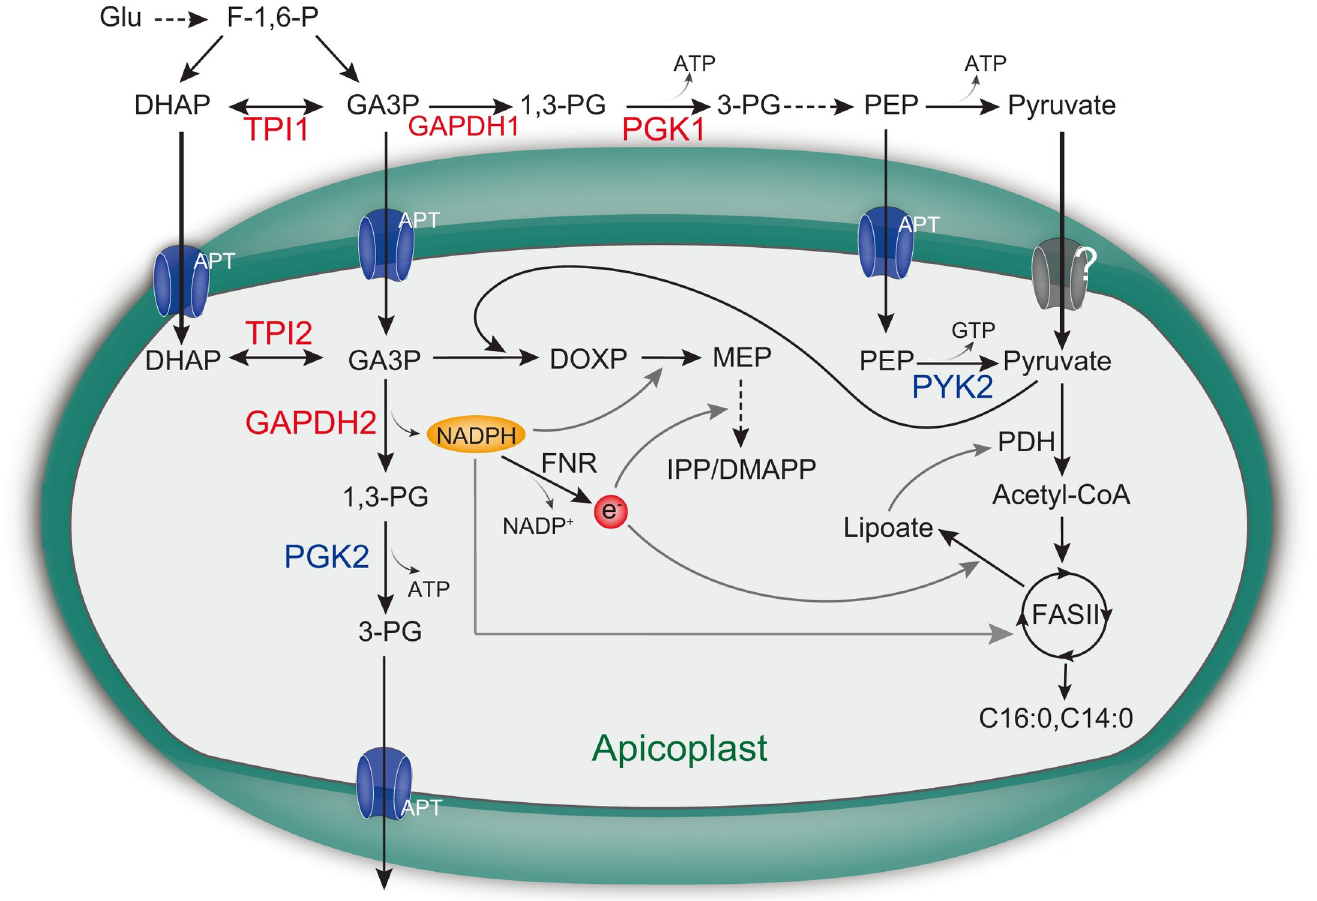
Fig 9. A model for the functions of glycolytic enzymes in T . gondii apicoplast. The apicoplast phosphate translocator (APT) imports a number of glycolytic intermediates into the apicoplast, including DHAP, GA3P and PEP. TPI2 catalyzes the interconversion of DHAP and GA3P, providing carbon source (GA3P) for the MEP pathway. The other substrate for the MEP pathway, pyruvate, may be acquired by multiple routes, through the conversion of PEP catalyzed by PYK2 and the direct import from cytosol by an unknown transporter. Dispensability of PYK2 suggests that direct import is probably the main source for pyruvate in the apicoplast. In addition, the lack of a strong growth defect of the Δ pyk2- Δ pgk2 mutant indicates additional source of energy to power apicoplast metabolism. GAPDH2 catalyzes the conversion of GA3P to 1,3-PG, along with the generation of reducing power in the form of NADPH, which is needed in the MEP pathway (by DOXPRI) and the FASII pathway (by FabG). In addition, NADPH may be a critical donor for electrons, via ferredoxin-NADP + reductase (FNR), to electron requiring enzymes like lipA during lipoate synthesis and IspG in the MEP pathway. The “?” mark denotes an unknown transporter that imports pyruvate from the cytosol.